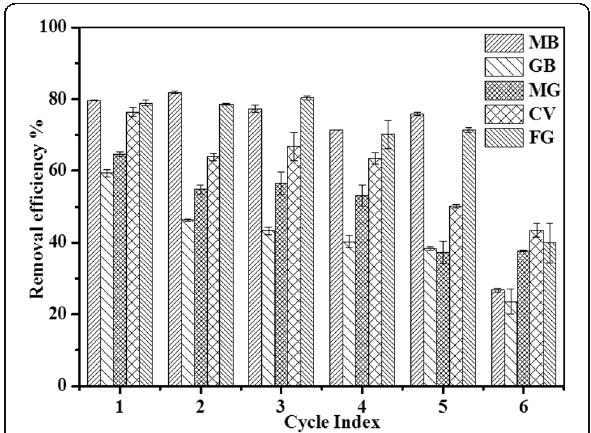
Fig. 9 The histogram of removal efficiency of cationic dyes by